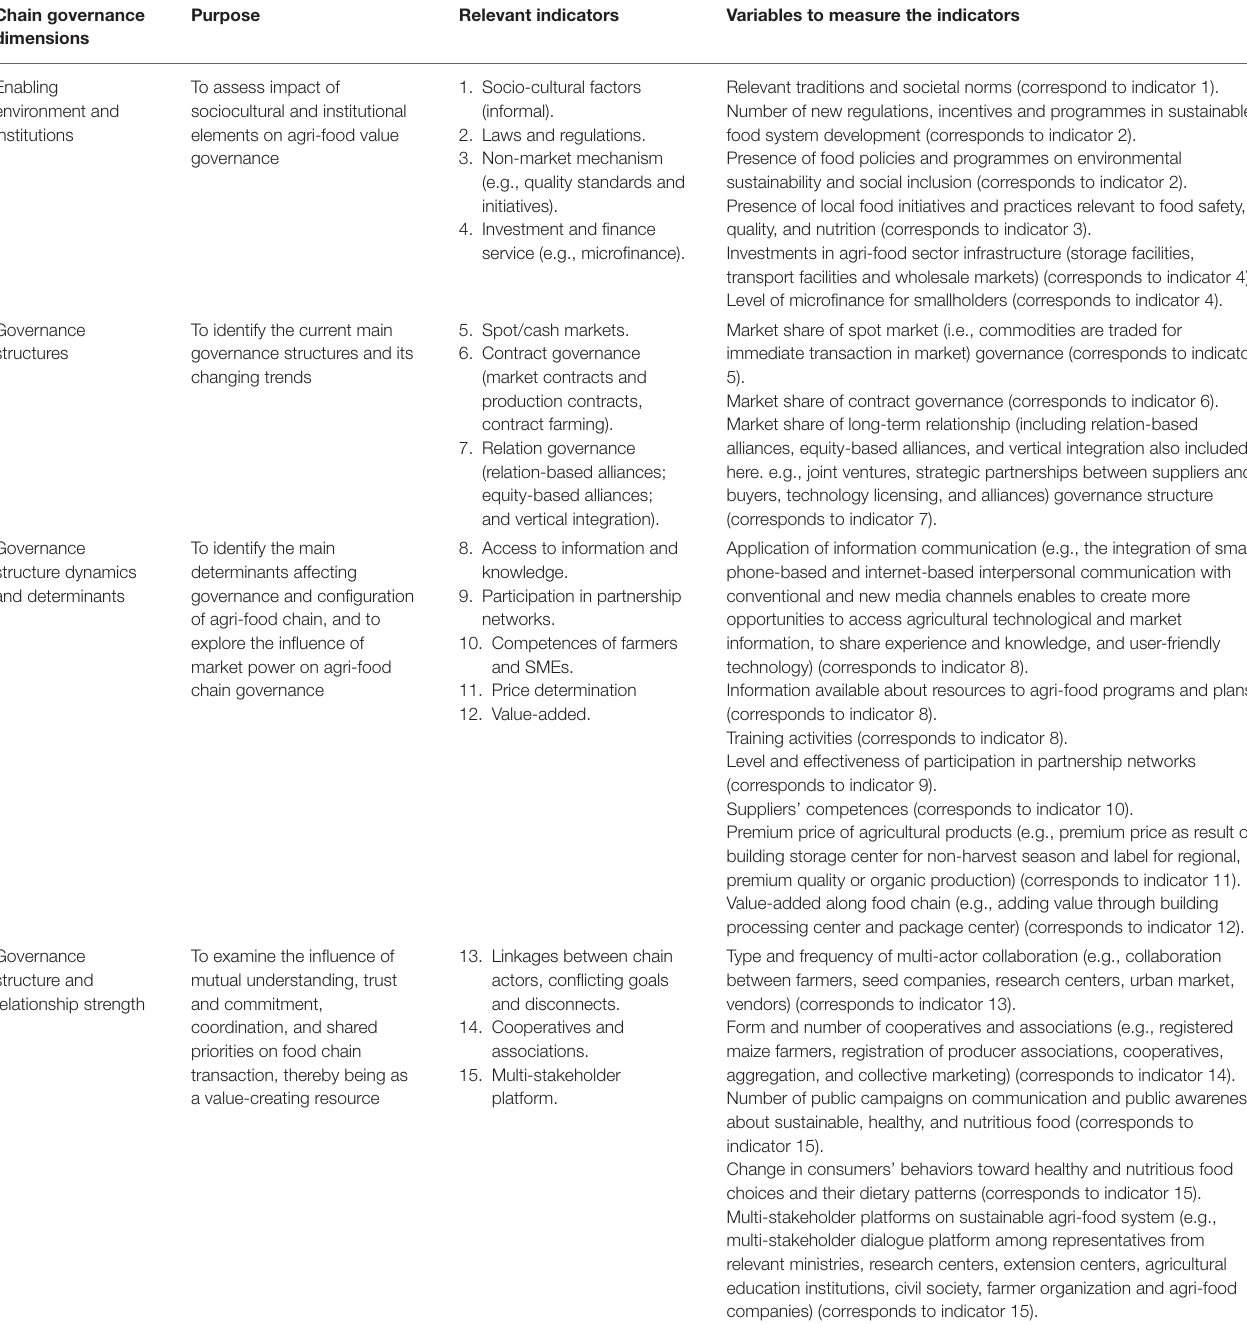
TABLE 3 | Food chain governance dimensions, relevant indicators and